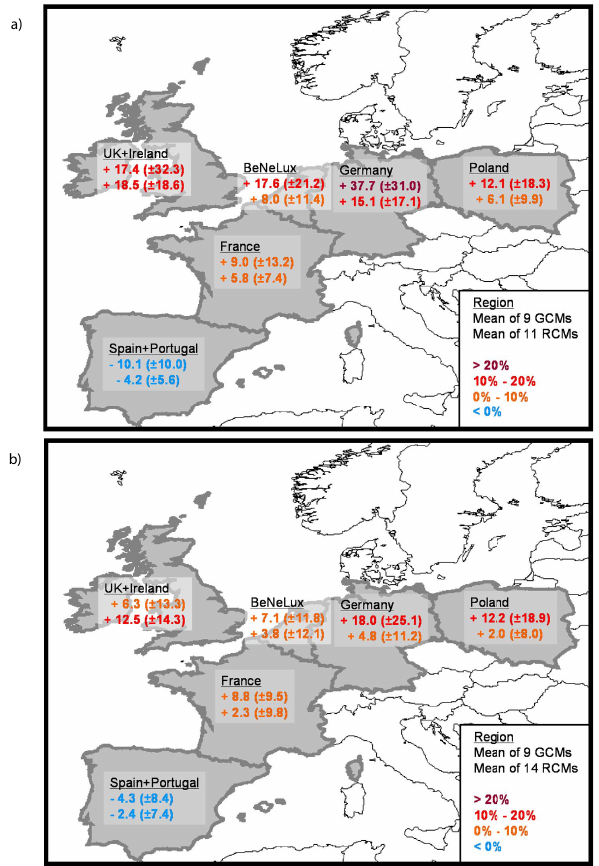
Fig. 4. Relative changes (unit: %) of mean annual storm loss poten- tial based on the GCM (upper row) and RCM (bottom row) simu- lations for the end (a) and middle (b) of the 21st century compared to recent climate conditions (20C, 1961–2000). Values in paren- theses are inter-model standard deviations. (a) End of 21C (2071– 2100), based on 9 GCM and 11 RCM simulations, (b) middle of 21C (2021–2050), based on 9 GCM and 14 RCM